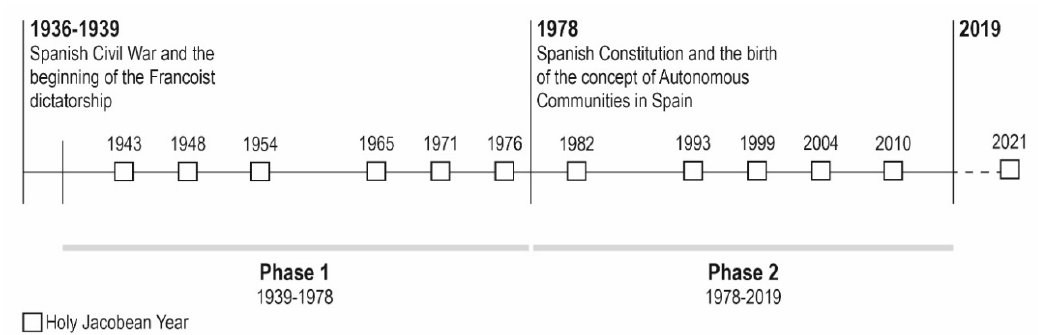
Figure 3. The timeline with two analysis phases (1939–1978 / 1978–present). Created by the authors. Each phase is analysed by presenting the (1) context, i.e., political / social / cultural situation characterising the phase, (2) main actors who actively contributed to Holy Year organisation actions in each phase, and (3) pilgrims, showing the data regarding turnout and